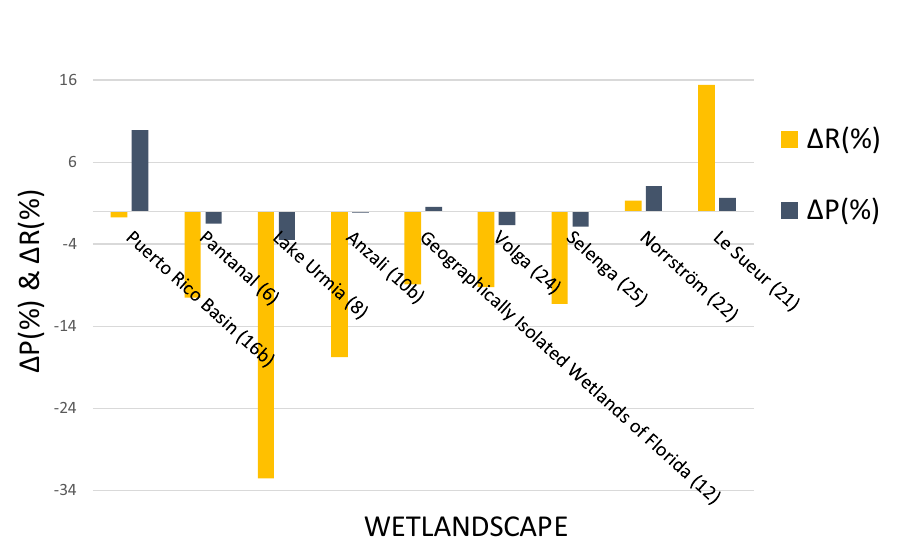
Figure 3. Relative change of precipitation and runoff for wetlandscapes with available discharge data. The nine wetlandscapes are here presented with name and corresponding ID number. The change in precipitation and discharge for the nine wetlandscapes corresponds to the different time periods in Table